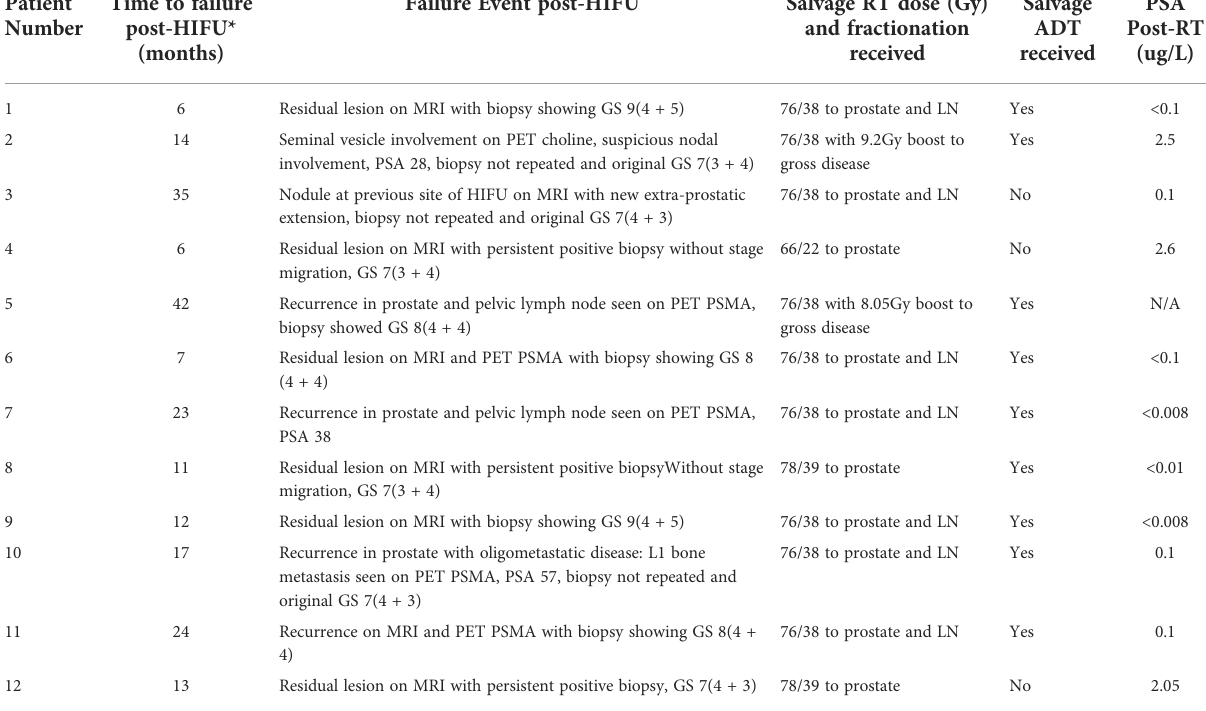
TABLE 2 Failure events and salvage